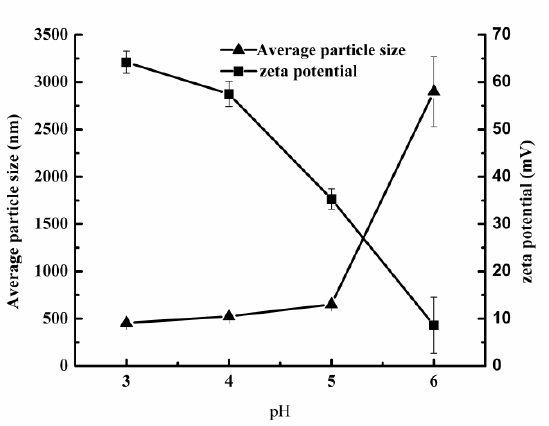
Figure 5. Effect of pH on average particle size and zeta potential of secondary emulsion. The pH value with the smallest particle size was selected for storage experiment. The storage stability of the secondary emulsion (pH = 3) within 21 days at room temperature was studied. As shown in Figure 6, with the increase in storage days, the average particle size of the emulsion increased slightly, and the zeta potential decreased slightly. On the 21st day, the zeta potential and average particle size of the emulsion were 56.7 mV and 473.3 nm, respectively, which showed no difference from the initial state. Therefore, the